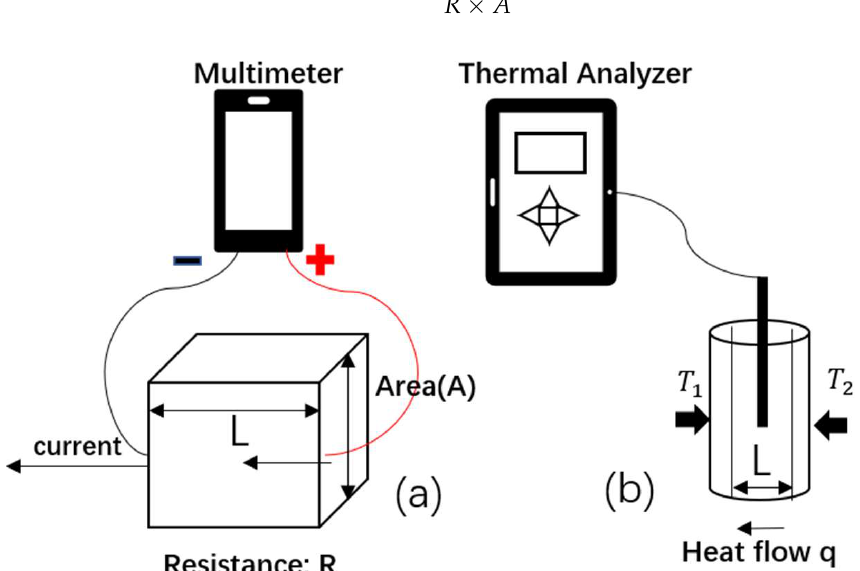
Figure 1. Illustration of ( a ) electrical conductivity measurement using a multimeter and ( b ) thermal conductivity measurement using a thermal property analyzer.